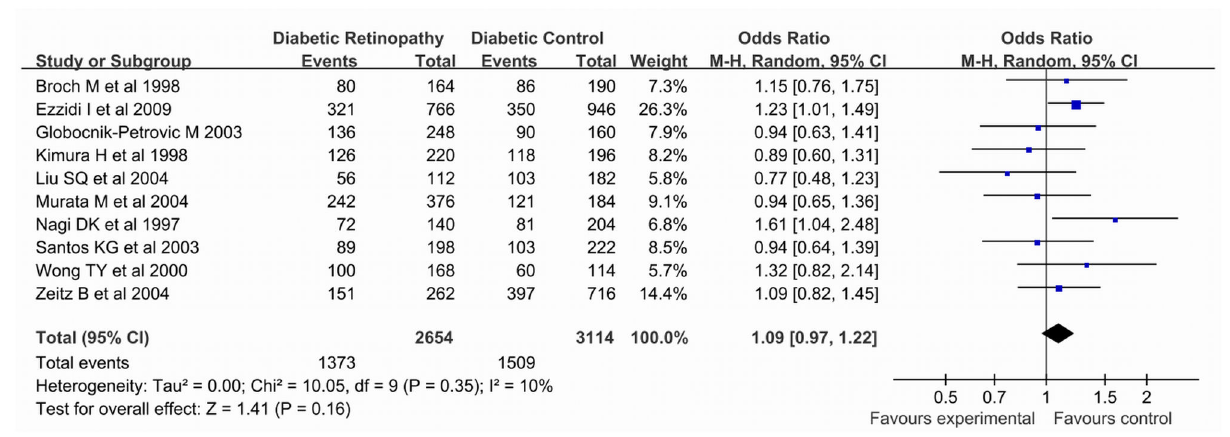
Figure 3. Pooled ORs for the association between the PAI-1 -675 4G/5G polymorphism (4G vs. 5G) and susceptibility to diabetic retinopathy. The area of the squares reflects the study-specific weight. The diamond shows the summary fixed-effects OR estimate from 10 studies.